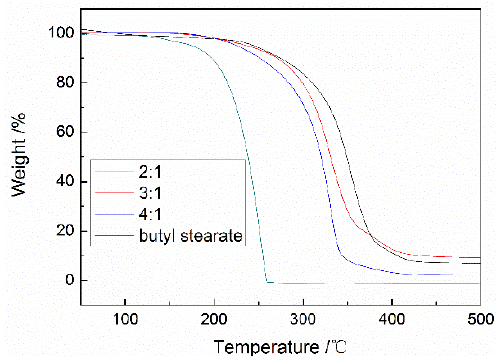
Figure 6. TGA curves of MicroPCMs with different core/shell ratio.